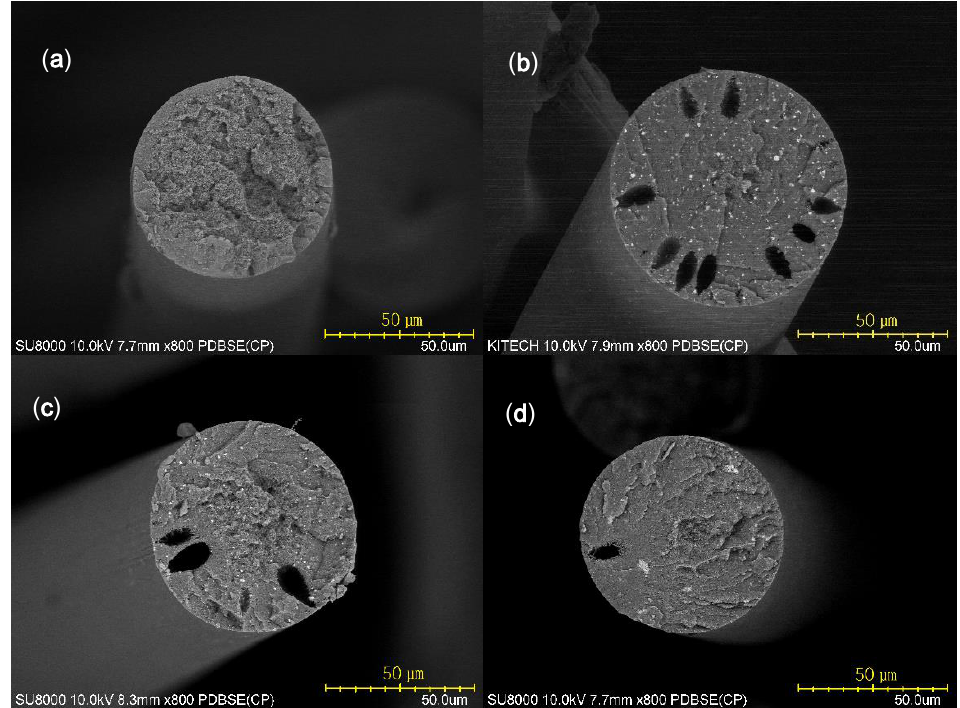
Figure 7. BSE-SEM images of the coagulated fiber cross section: ( a ) PANVDC, ( b ) PANVDC-ATO, ( c ) PANVDC-ATO/ZHS, and ( d ) PANVDC-ZHS.